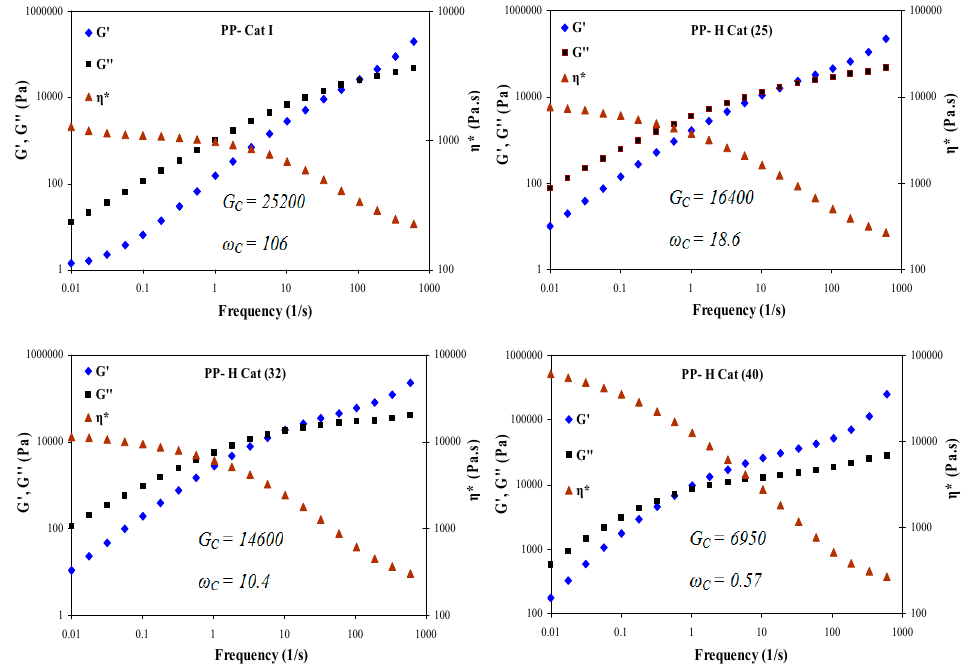
Figure 7. G ’, G ” and η * values in terms of frequency for the synthesized PP reactor blends with different molar ratios of cat (II)/cat (I).